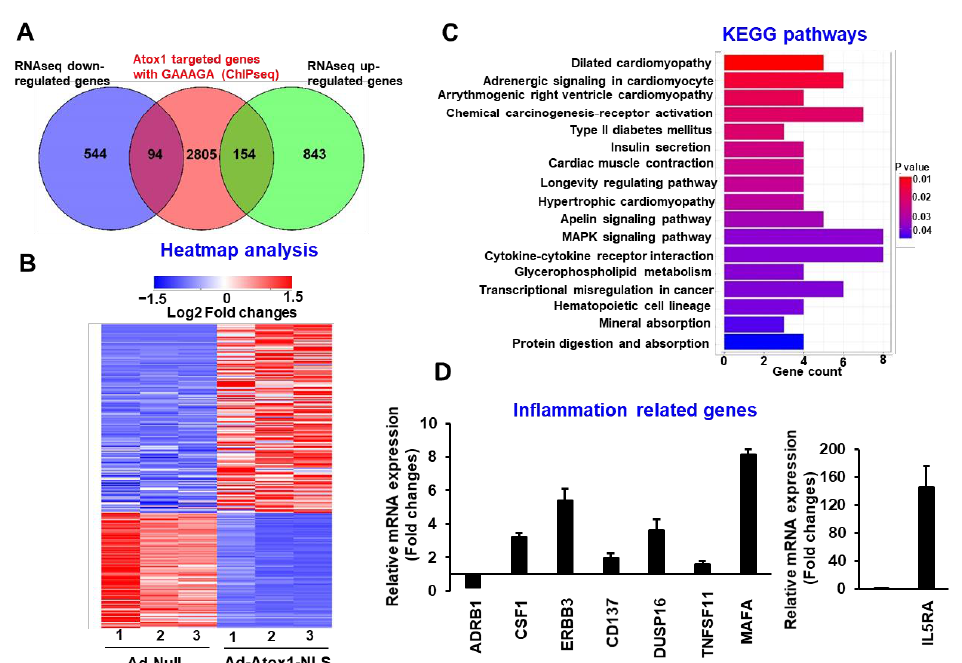
Figure 5. Genome-wide identification of direct Atox1 target genes. ( A ). Venn diagrams showing the overlap of DEGs directly regulated by Atox1, which are genes differentially expressed as identified in RNA-Seq and bound by Atox1 via Atox1 binding motif (GAAAGA) identified in ChIP-Seq. ( B ). Heatmap of expression pattern for those DEGs directly regulated by Atox1 as shown in ( A ). ( C ). KEGG pathway enrichment analysis of those 248 DEGs as shown in A. The 17 enriched pathways with p < 0.05 are shown here. ( D ). Subset of the Atox1 regulated gene targets was validated by quantitative RT-PCR (n = 3).